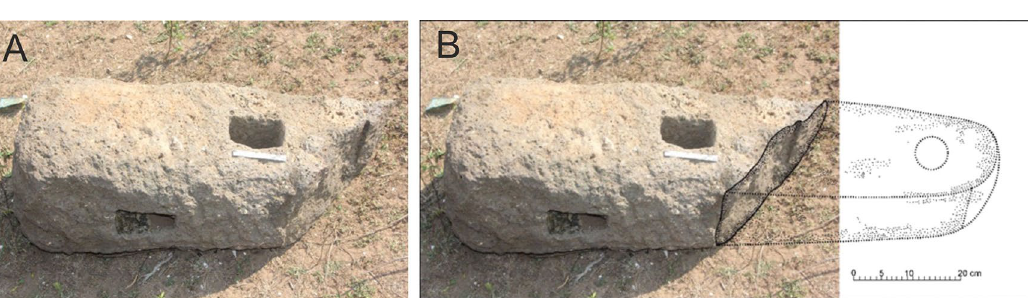
Figure 2. Figure showing the location of Manikapatna and nearby localities around the Chilika Lake, state of Odisha, India.